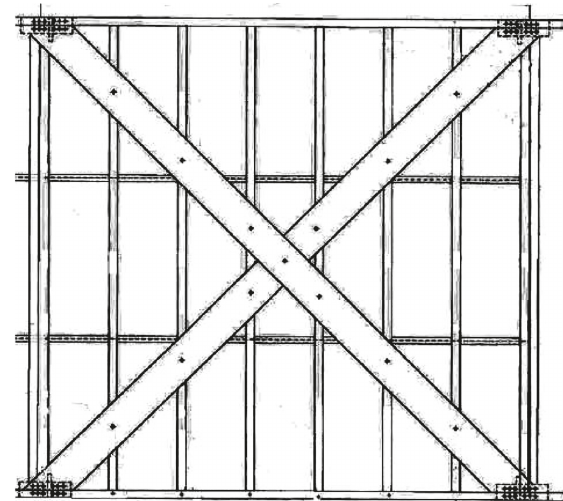
Figure 3: Details of connecting the bracing of diagonal straps to the middle part in the braced